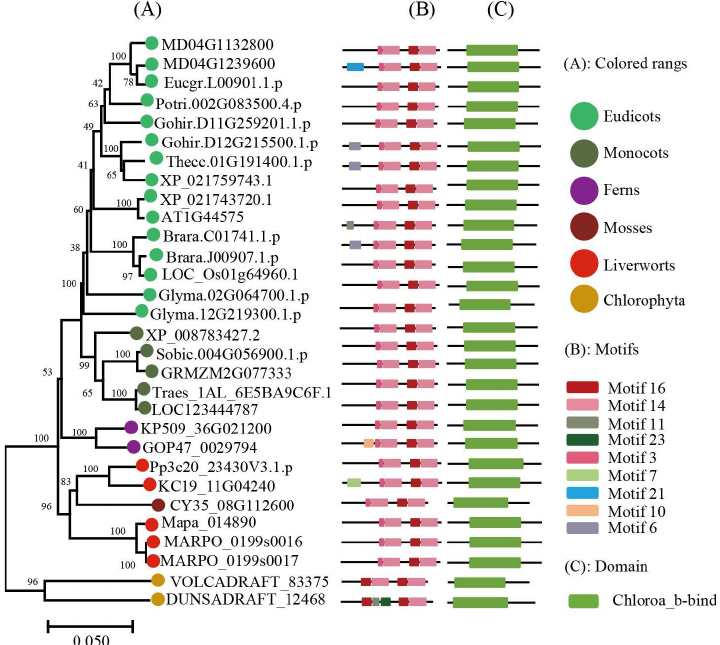
Figure 6. Phylogenetic evolutionary tree, protein motifs, and domains of the PsbS subfamily members: ( A ) Unrooted phylogenetic tree of the PsbS subfamily; ( B ) motifs of the PsbS proteins. The different colors indicate nine motifs (left panel); ( C ) protein domains of the PsbS genes.